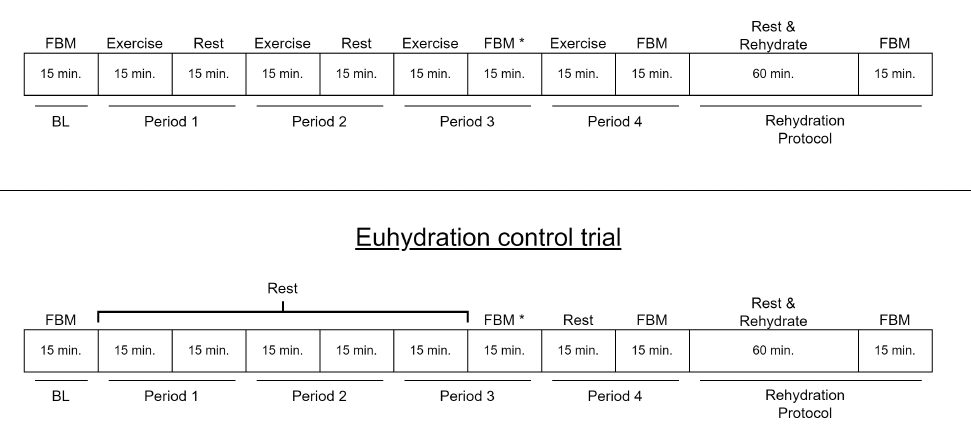
Figure 4. Timeline of events in each treatment condition. Fluid balance measurements (FBM): nude body weight, urine specific gravity, hematocrit and S21 measurement; * Period 3 FBM: urine specific gravity was not assessed. BL: